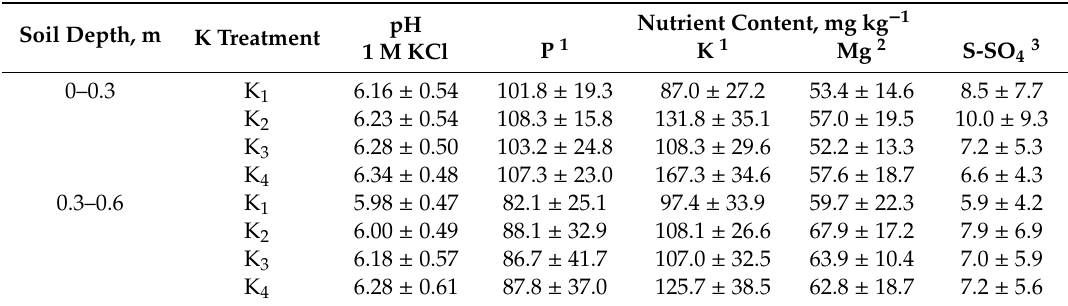
Table 1. Soil chemical properties in early spring as a result of stationary long-term field experiments, varied K fertilization (mean ± standard error of mean for